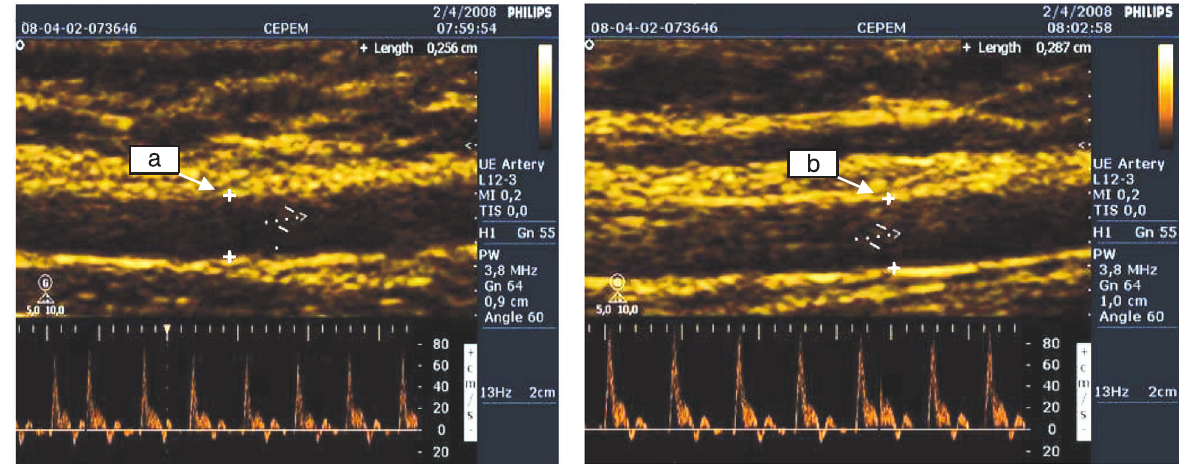
Figure 1. Brachial artery images obtained before arm pressure (a) and 60 s after deflation